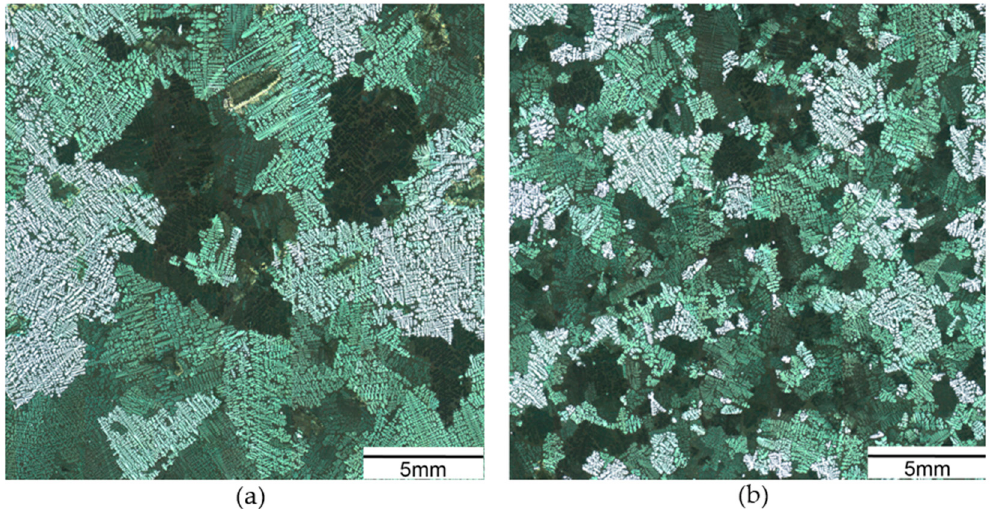
Figure 10. Macrostructures in the longitudinal section observed by microscope with polarized light: